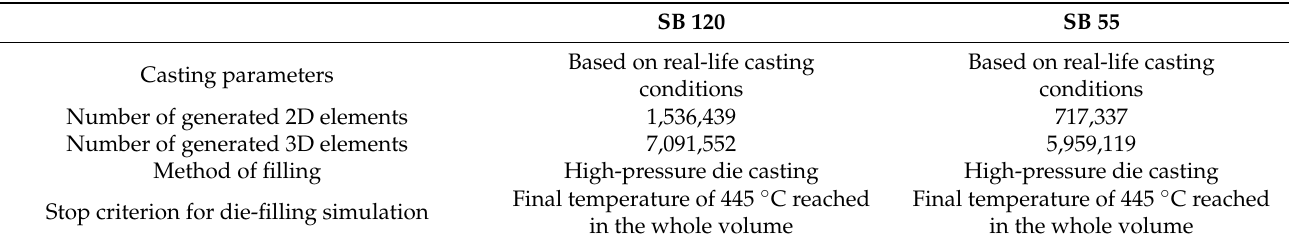
Table 3. Simulation input conditions and parameters.